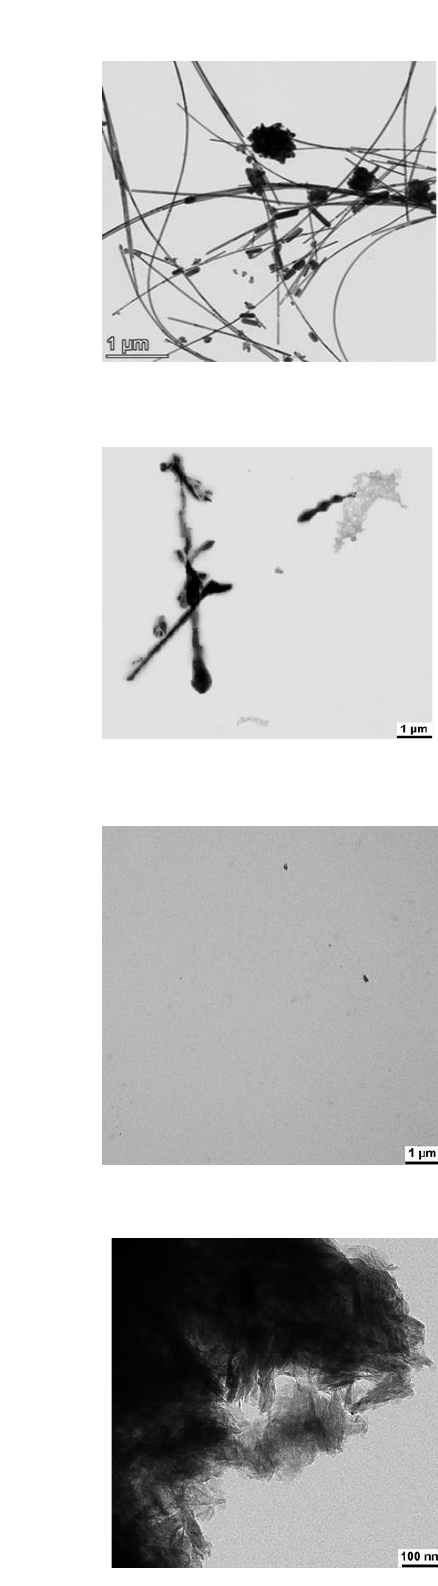
Figure 1. TEM images of NP and NW before and after treatment in the flow-through cells with phagolysosomal simulant fluid (PSF).